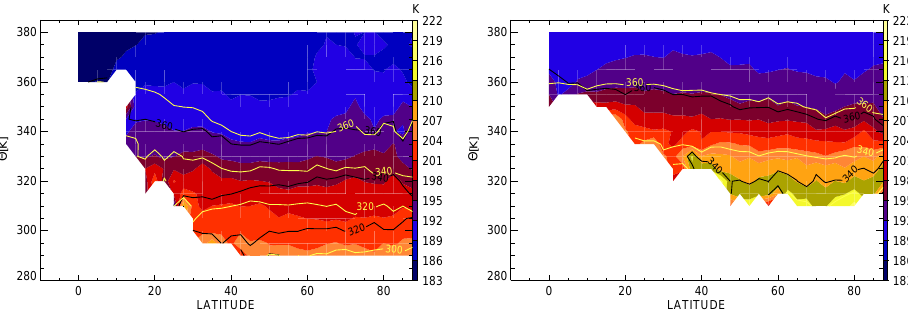
Fig. 5. As Fig. 3 but for the Lagrangian cold point temperature T LCP of TST trajectories projected to t =0 for northern winter (left) and summer (right). Warm colours denote higher temperatures, contours show potential temperature Θ [K] during TST (yellow) and at LCP (black), which are also projected to t =0.